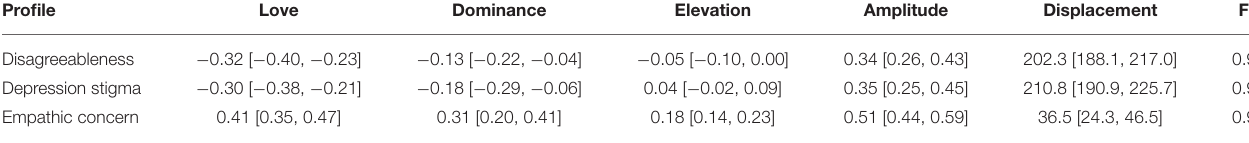
TABLE 4 | Structural summary parameters with 95% confidence intervals in Study 2.